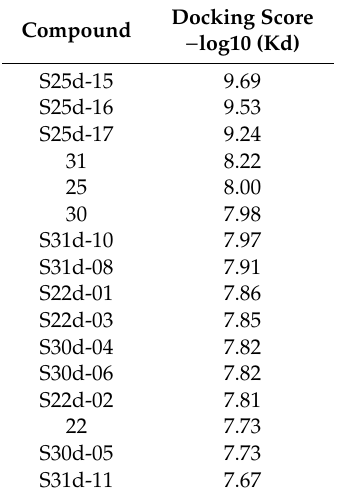
Table 5. HDAC4 docking scores of cyclopropane derivatives having heteroatoms in the innermost aromatic ring of the core of the sca ff